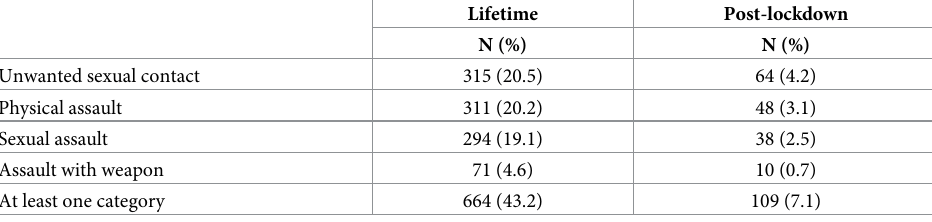
Table 3. Reported experiences of violence, by category (N =